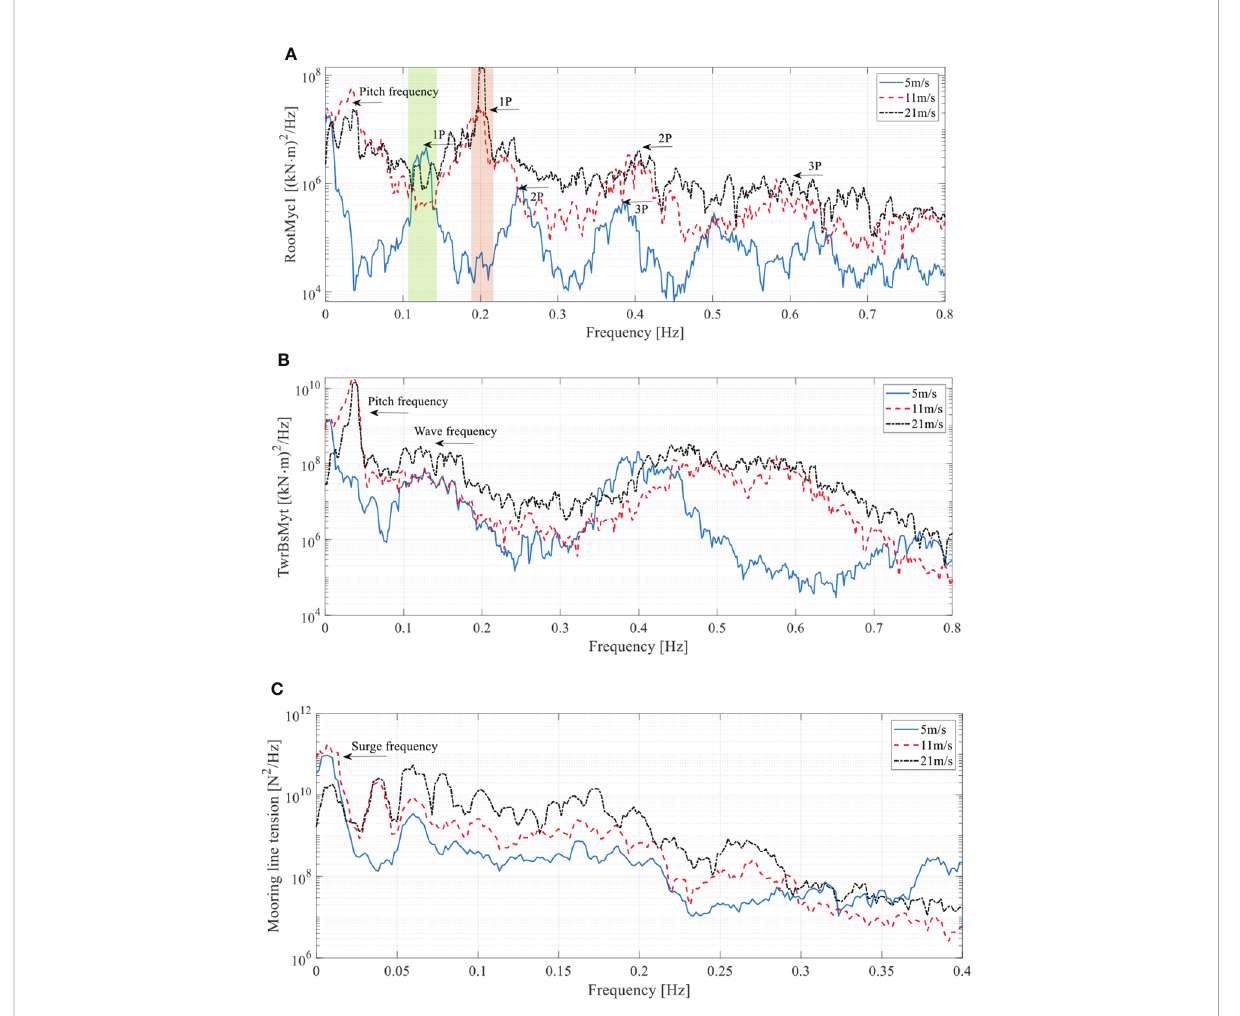
FIGURE 7 PSDs of the blade root out-of-plane bending moment (A) , tower base fore-aft bending moment (B) , and mooring line tension (C)